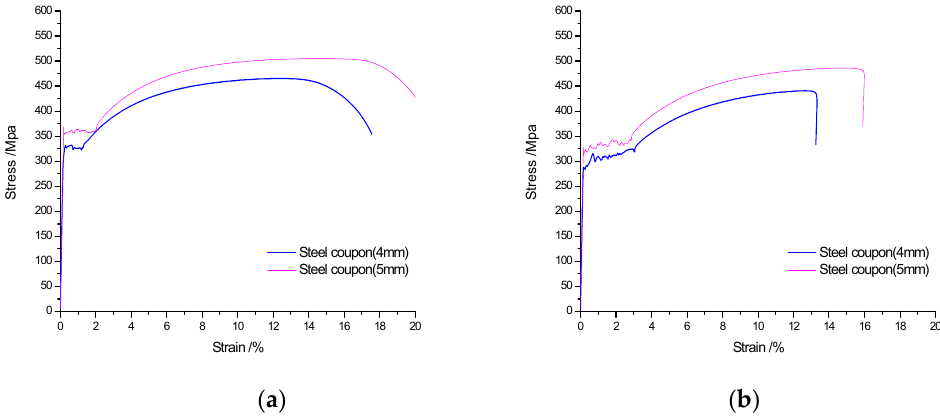
Figure 3. Stress–strain curves of the steel. ( a ) The curves before fire; ( b ) The curves after fire. Table 5. Test results of steel plate properties.